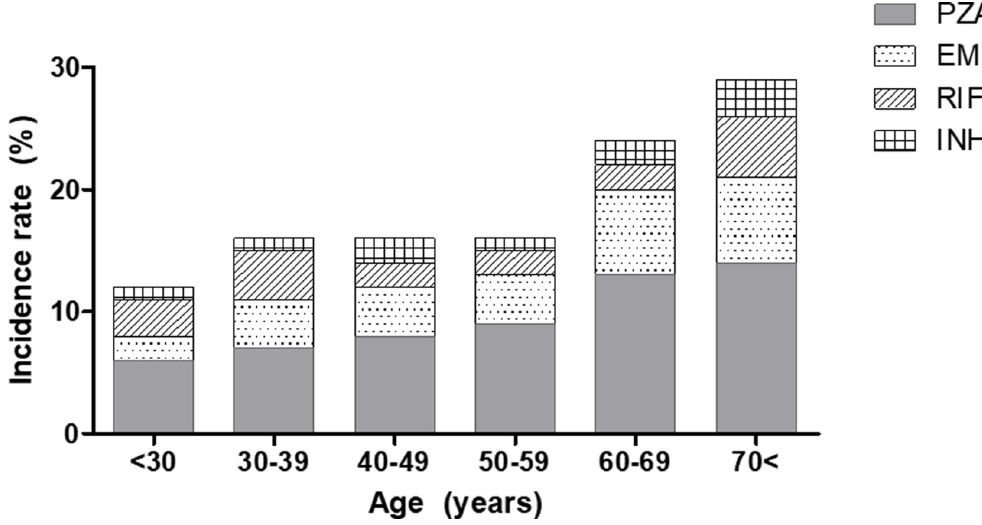
Fig 3. Incidence of serious adverse events due to pyrazinamide according to age group.